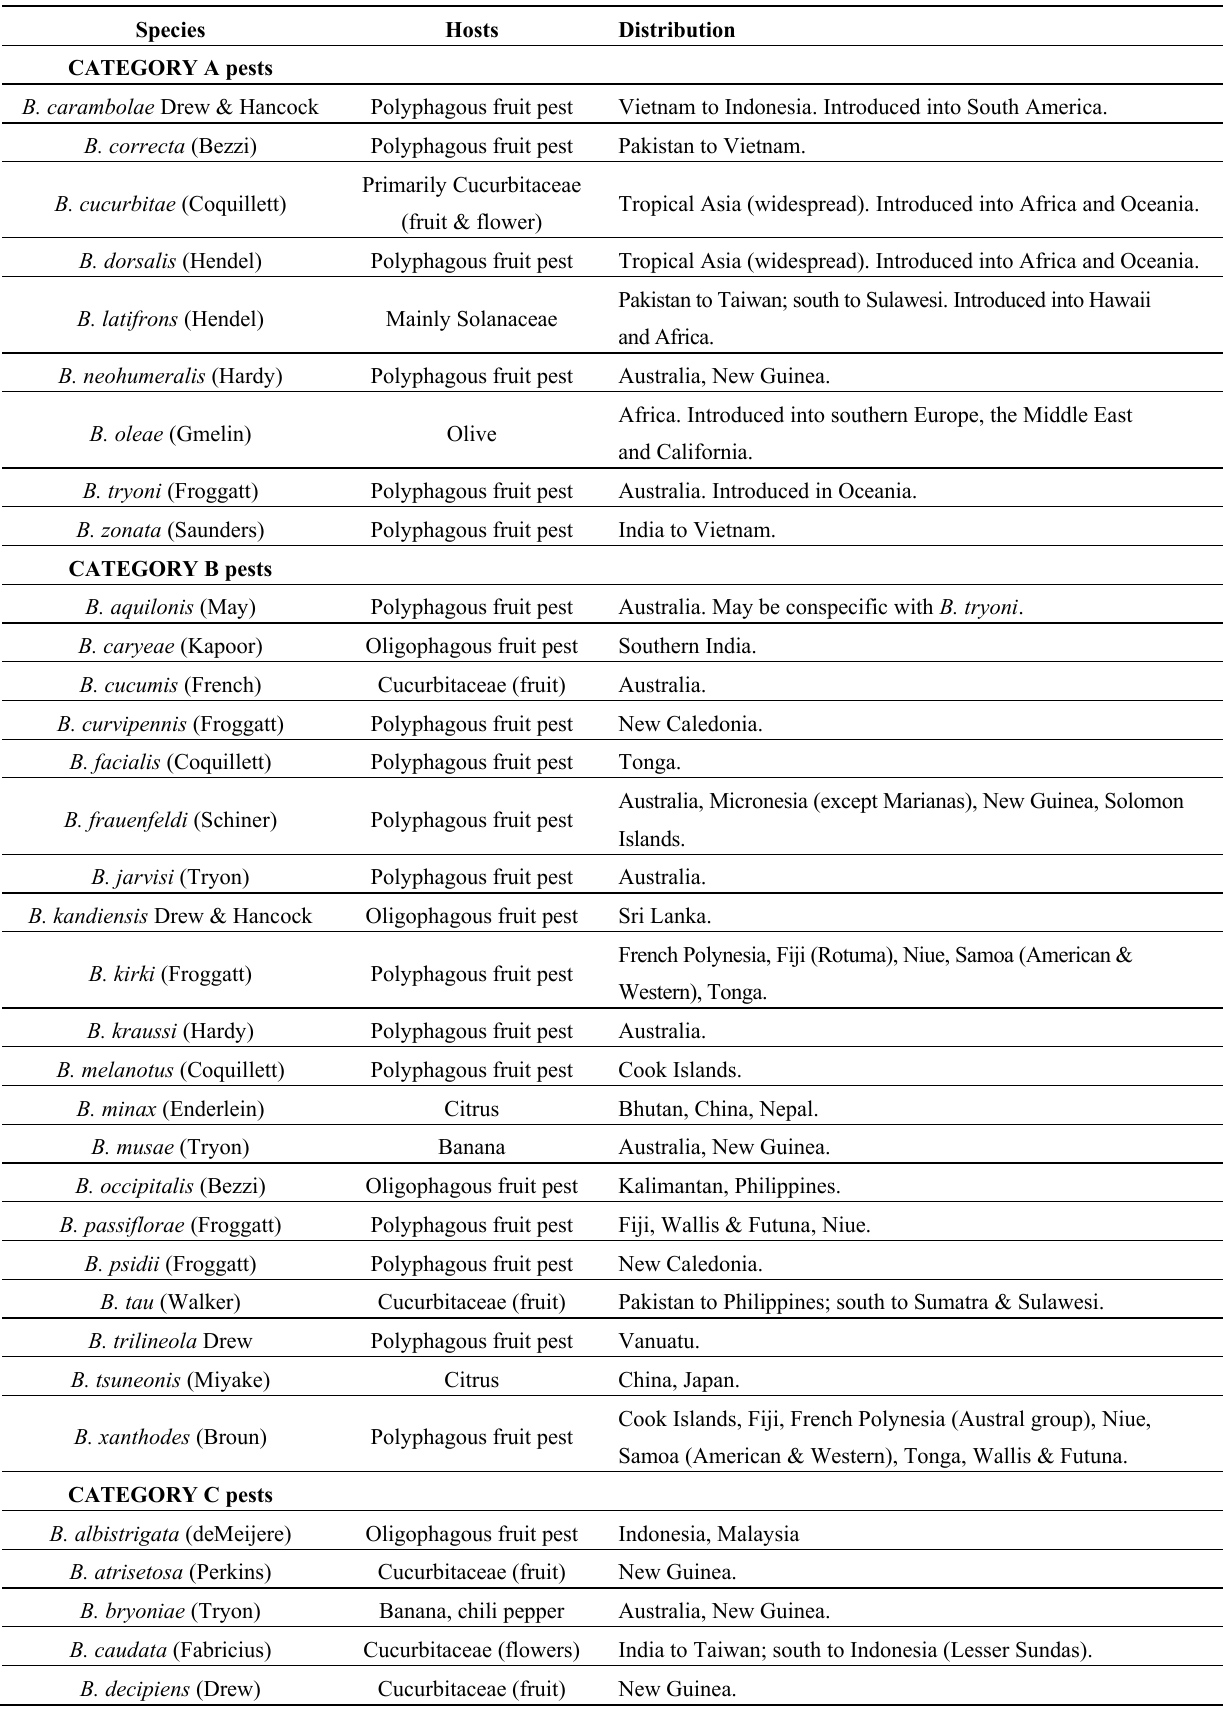
Table 1. List of pest species of Bactrocera , ranked by category of severity.